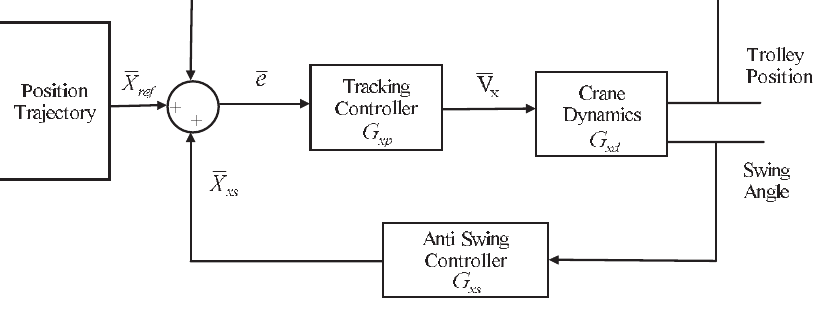
Fig. 7. Schematic diagram for the second anti-swing controller.